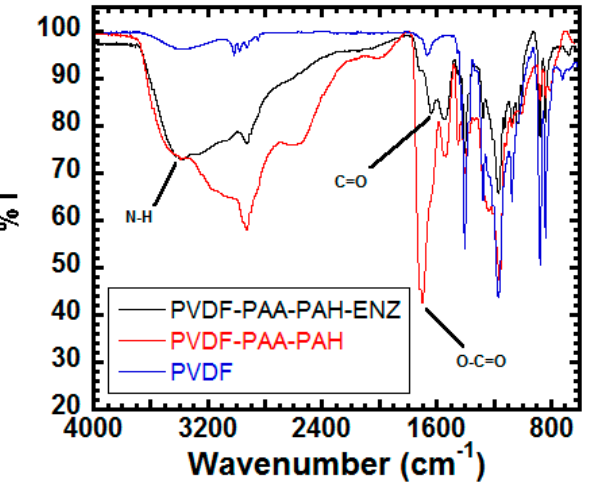
Figure 1. Comparison of ATR FT-IR spectra of PVDF, PVDF-PAA-PAH and PVDF-PAA-PAH-ENZ membranes.